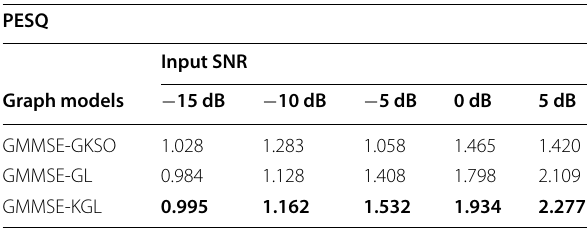
Table 1 The PESQ of the different graph models followed by the GMMSE method